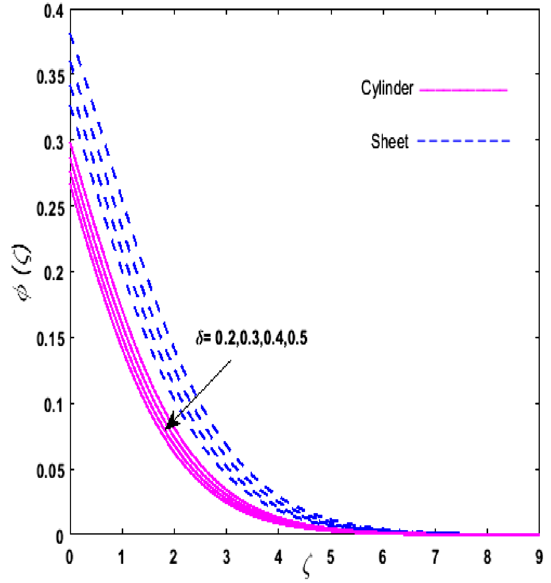
Figure 14. Upshot of δ on φ(ζ) .